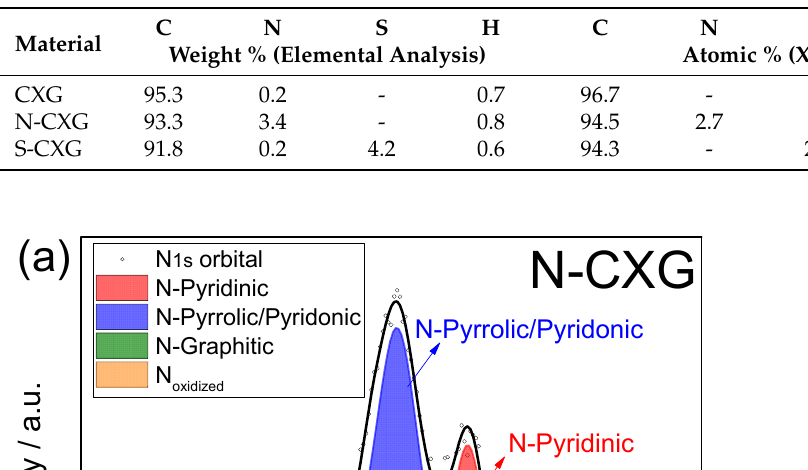
Table 2. Chemical composition for CXG, N-CXG and S-CXG determined from elemental analysis and XPS.